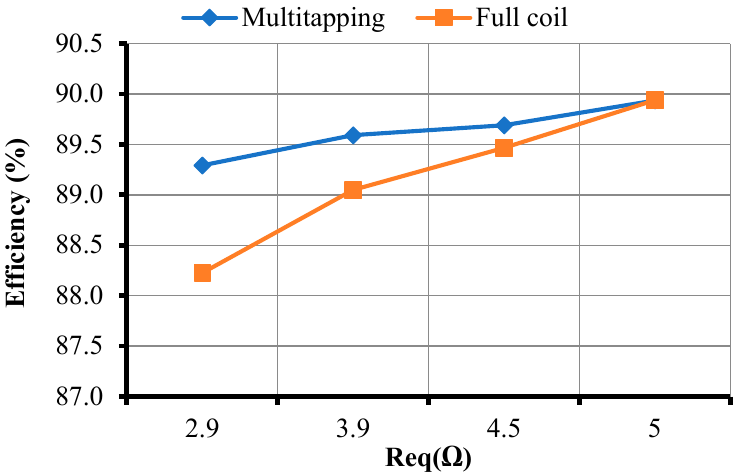
Figure 19. Efficiency of the system with and without multi ‐ tapping.